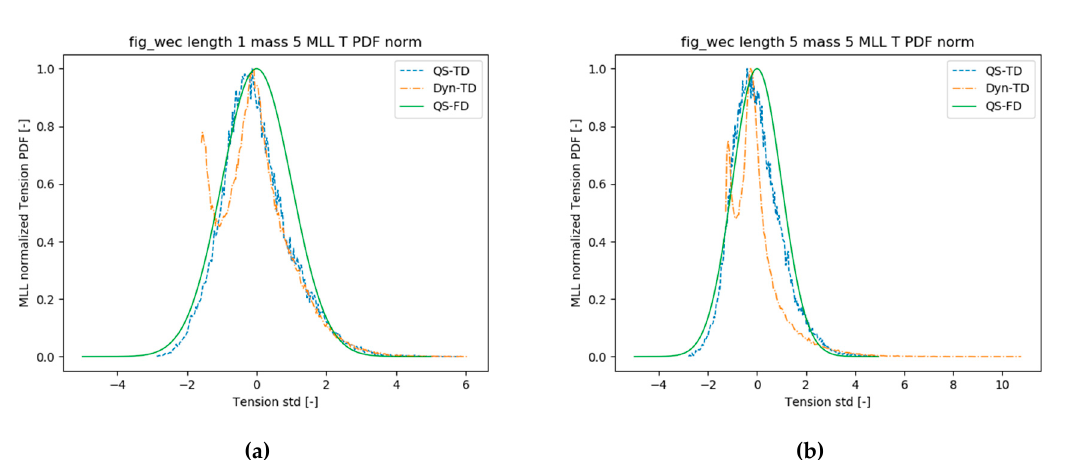
Figure 13. Normalized PDFs of the most loaded line with the three approaches. High pretension (a) and low pretension (b).